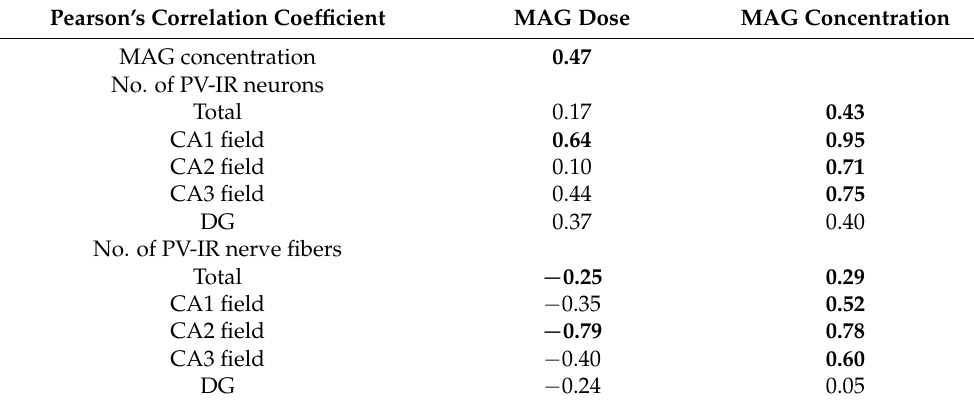
Table 2. Pearson’s correlation coefficients (r) between the dose of magnoflorine and its concentration in the mouse hippocampus and its impact on PV-IR neurons and the number of PV-IR nerve fibers in different fields (CA1, CA2, and CA3) and the DG. Values of correlation coefficients in bold are statistically significant ( p ≤ 0.05).